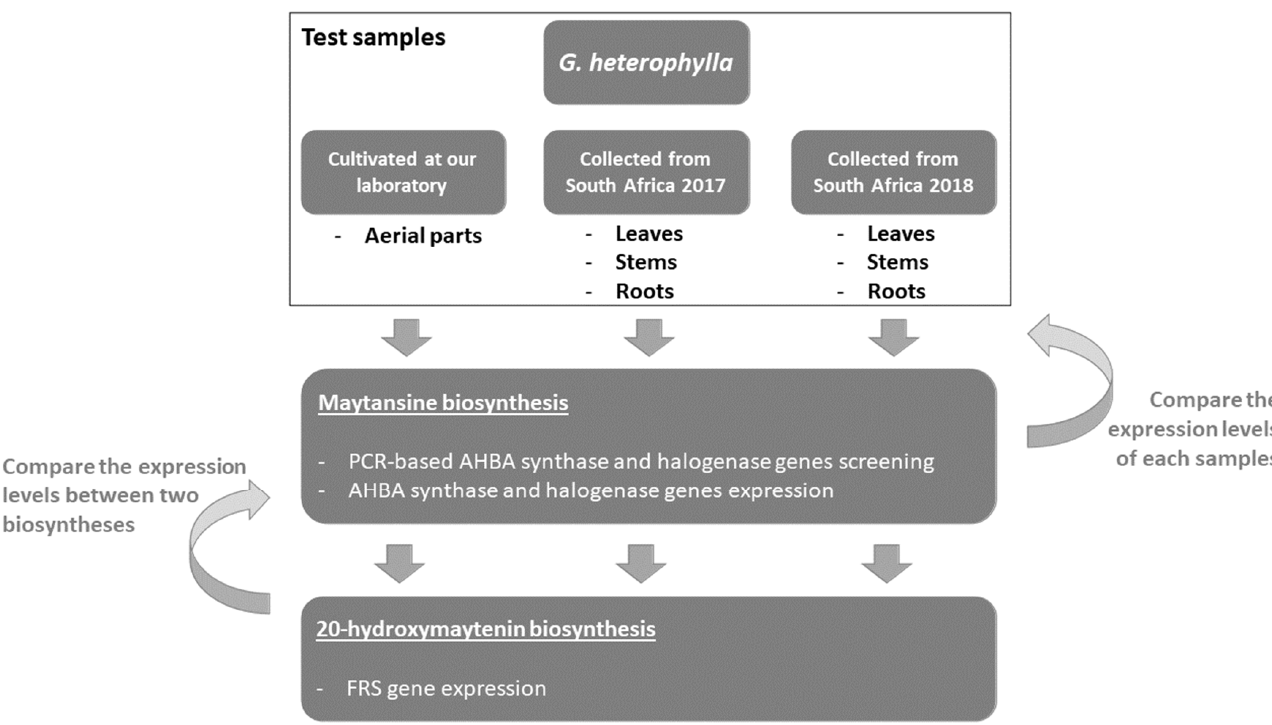
Figure 2. Experimental scheme showing the design and techniques applied in this study.